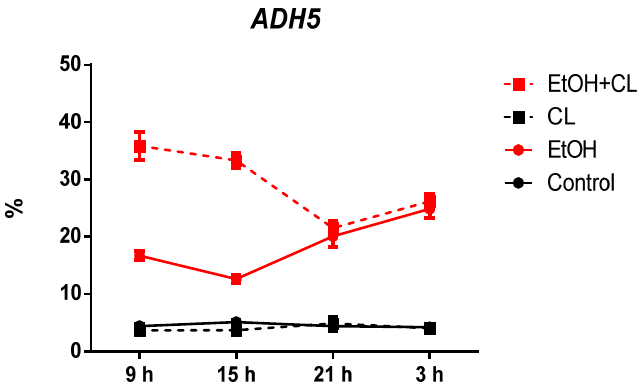
Table 3. Results of the cosinor analysis of the daily dynamics of the expression of the studied genes.